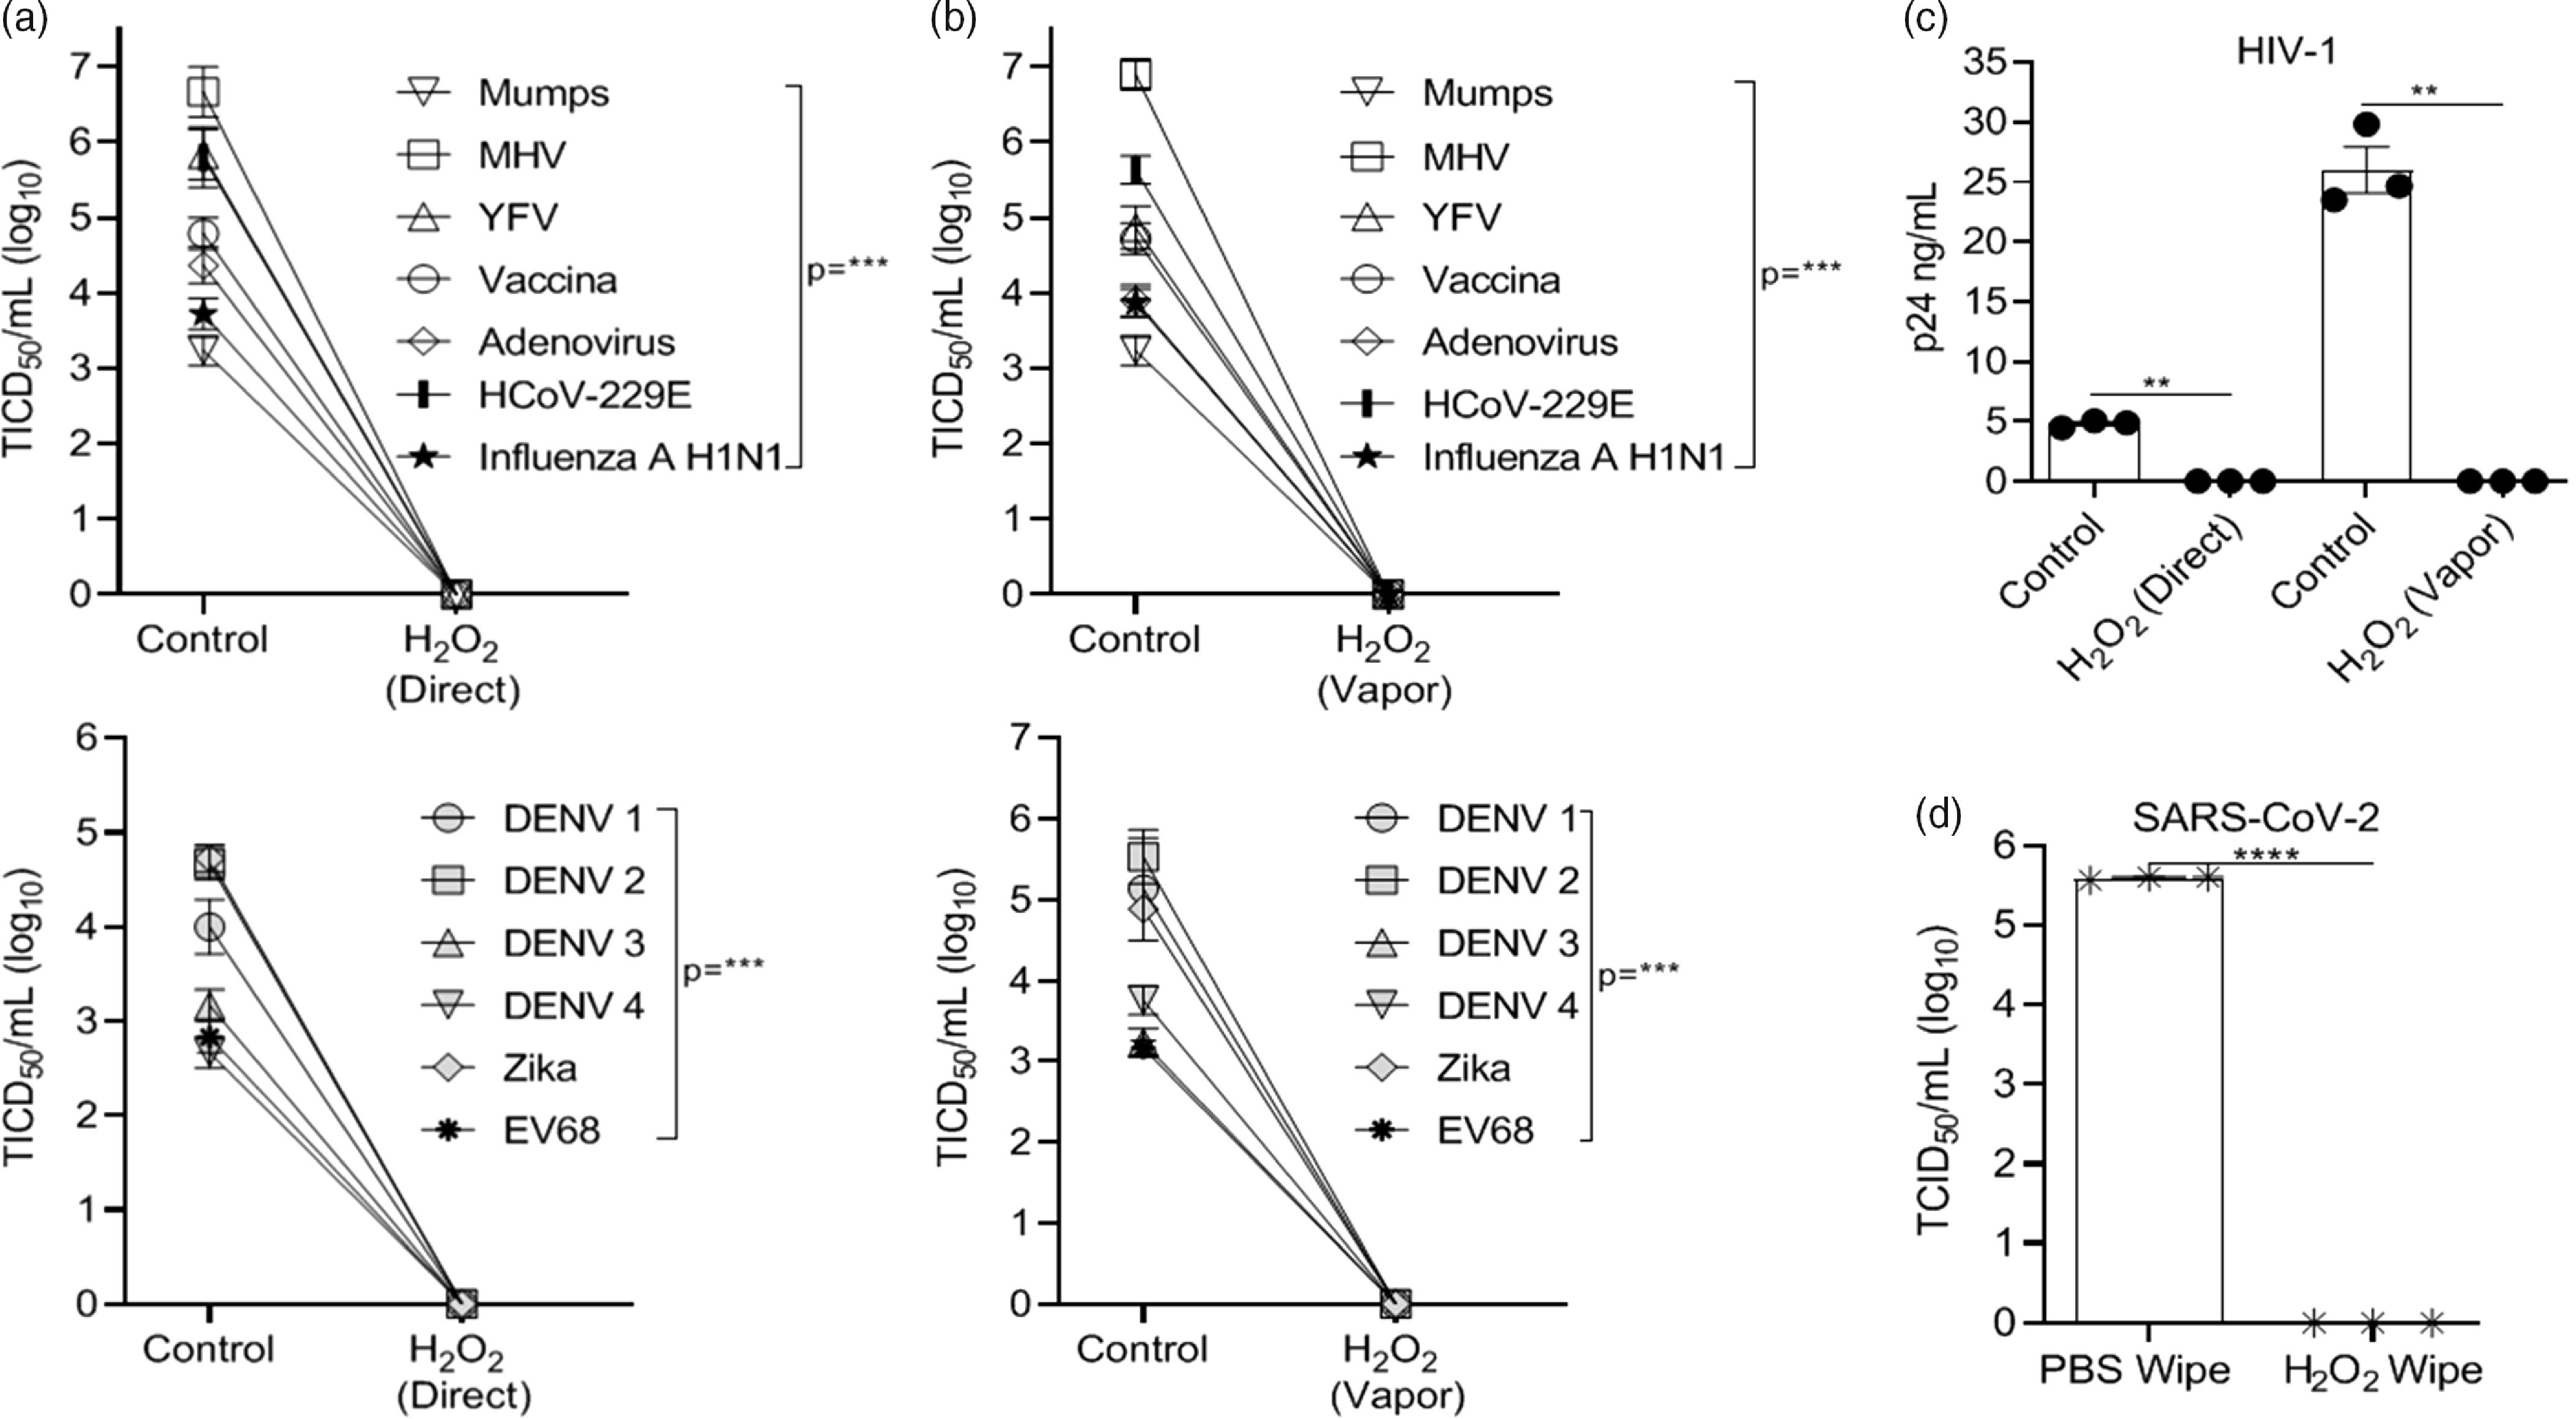
Hydrogen peroxide (H2O2) inactivation on 3D-print material by application method versus controls. Virus recovery from 3D printed mask material after exposure to ionized H2O2 (3%) in (A) direct contact or (B) vaporized application format. (C) Recovery of HIV-1. Virus applied to 3D material without exposure to H2O2 acted as control. (D) Recovery of SARS-CoV-2 virus from 3D-printed mask material after exposure to a single-wipe application of phosphate-buffered saline (PBS) or H2O2 (3%). Virus titer was completed as described in the Methods section in the cell type indicated in Table 1. Significance was determined using the Student t test. *P < .05; **P< .01; ***P < .001; ****P < .0001; ns, not significant. Error bars represent standard error of the mean (SEM) of triplicate experiments. Note. DENV, dengue virus.